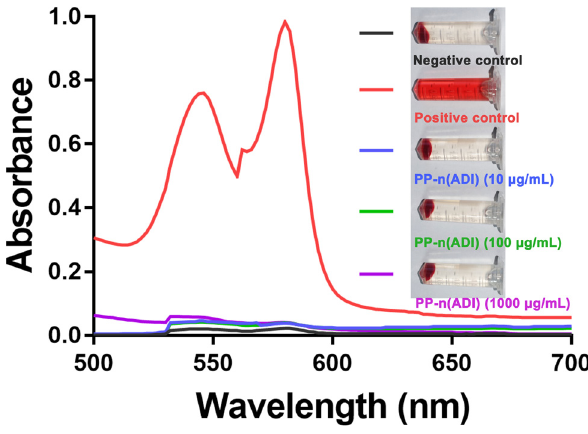
Figure 9: Hemolytic activities of PP - n ( ADI ) and comparison with saline ( negative control ) and distilled water ( positive control